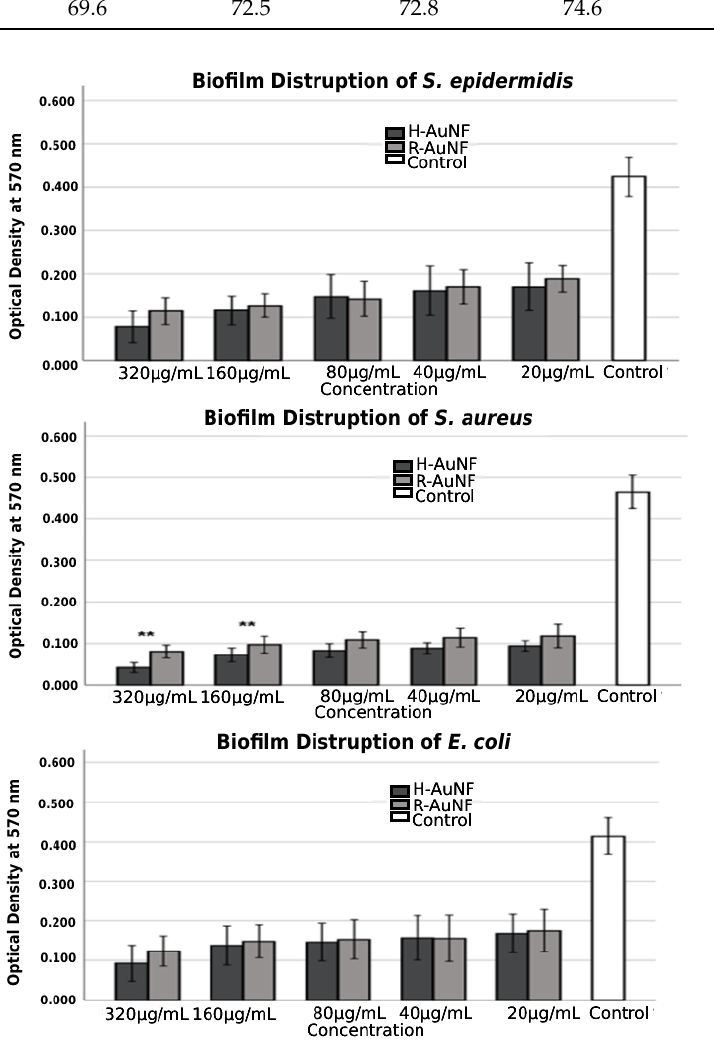
Figure 9. Biofilm disruption activity of AuNFs against selected bacteria strains at various concentra- tions. The error bars symbolized the SD of error mean (** p < 0.01).